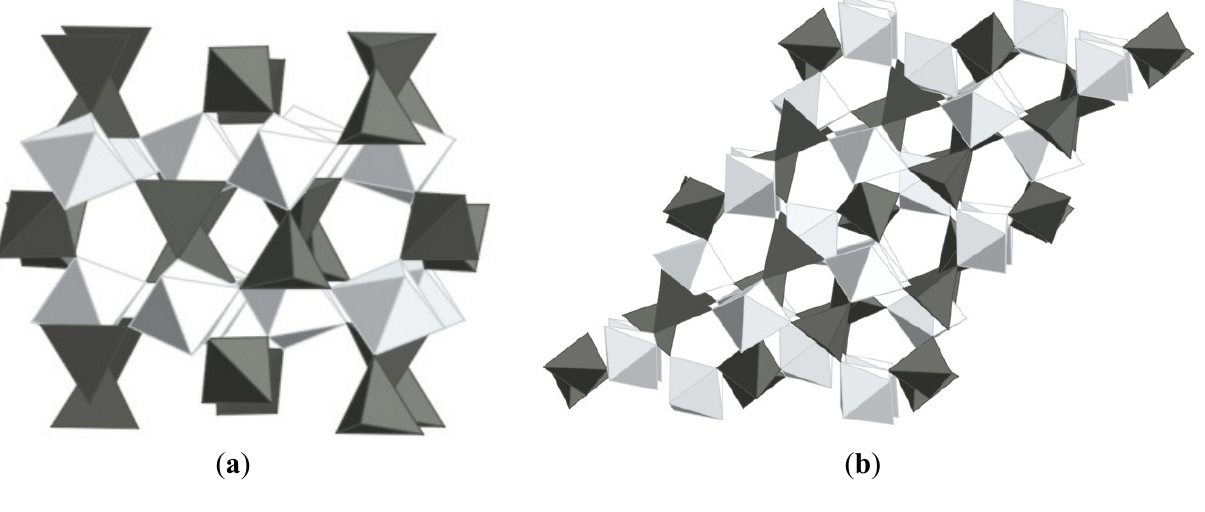
Figure 5. Crystal structures of ( a ) orthorhombic; ( b ) monoclinic Al octahedra; dark: MoO